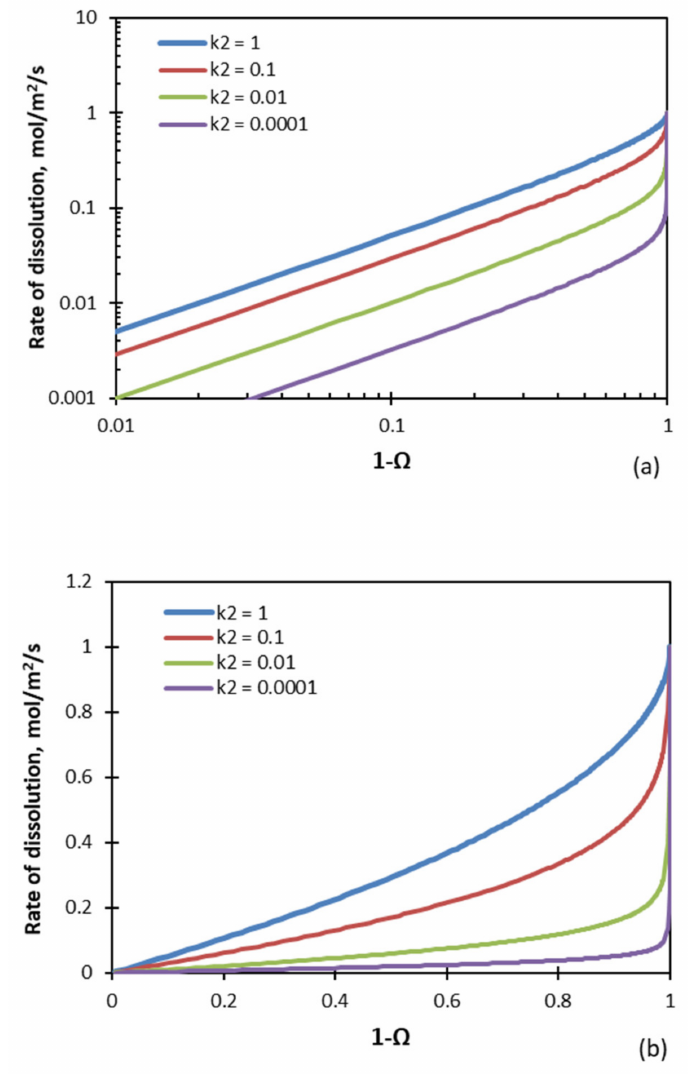
Figure 12. The rate of dissolution as a function of the degree of saturation, Ω , for different values of the parameter k 2 in Equations (23) and (32) as ( a ) a log–log plot and ( b ) a normal coordiante plot. Saturated conditions are on the left and reaction control on the right-hand side of the figures. The rate far from equilibrium (at Ω = 0) has a value of 1.0 for all curves. The other parameters have the following values: K = 1, k 1 = 1, t =